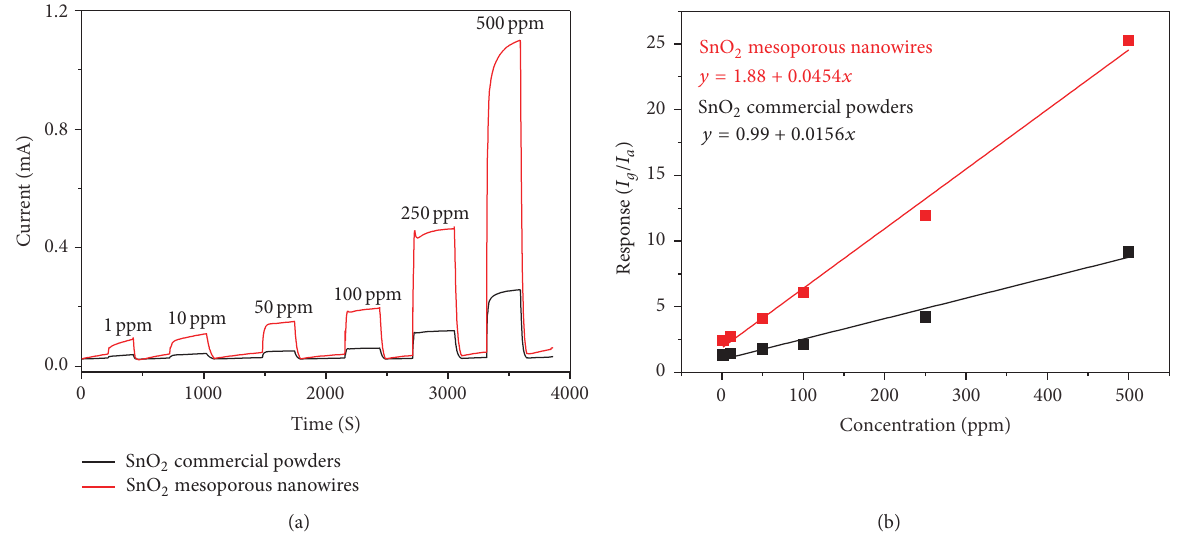
Figure 5: Real-time response curves of the mesoporous SnO 2 nanowires and SnO 2 commercial powders, ethanol, and (b) the corresponding plots of the response versus